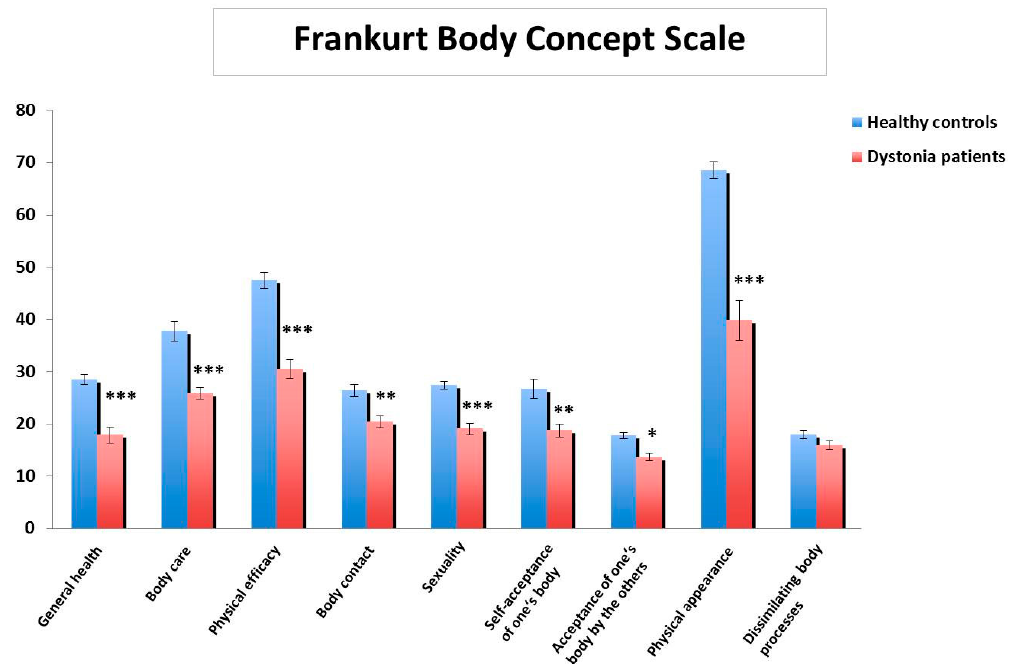
Figure 1. Frankfurt Body Concept Scale subscale scores in patients with dystonia ( n = 20) in comparison to healthy controls ( n = 25) indicate significant impairment in patients with dystonia in most domains; scores are presented as means ± SEM. * p < 0.05, ** p < 0.01, *** p < 0.001.